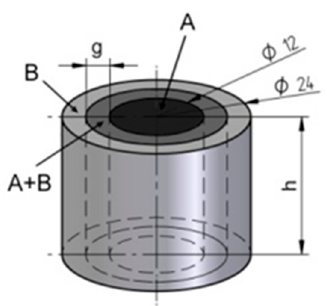
Figure 1. Sketch of the sintered product (dimensions in millimeters).